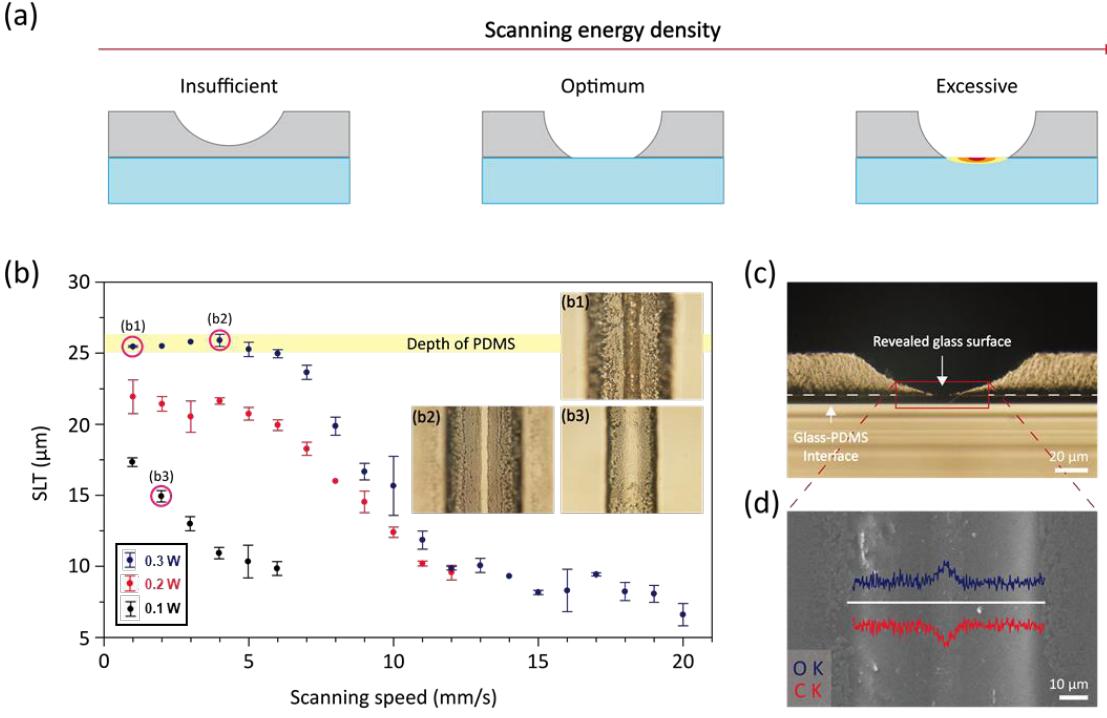
Figure 2. ( a ) Schematics representing substrate conditions according to scanning energy density, ( b ) Parametric study for SLT according to laser parameter and optical microscopy images of ( b1 ) for excessive, ( b2 ) for optimum, and ( b3 ) for insufficient, ( c ) Cross-section optical microscopy image in case of ( b2 ), ( d ) Top view FE-SEM image and contents data of oxygen and